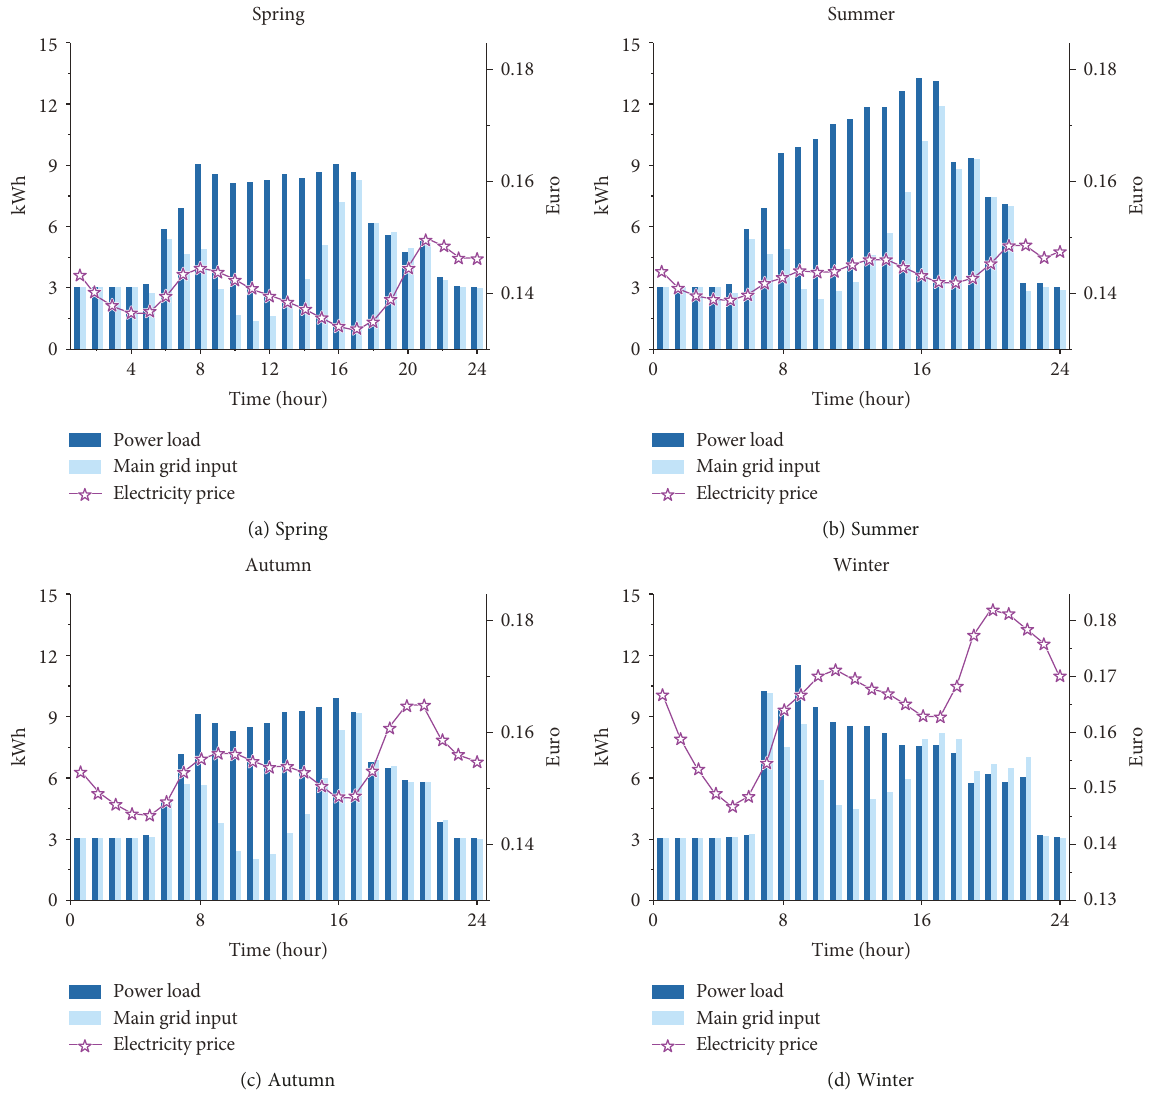
Figure 15: Comparison between electrical grid supply without the EH system and with the advanced EH system for di ff erent representative days for the four